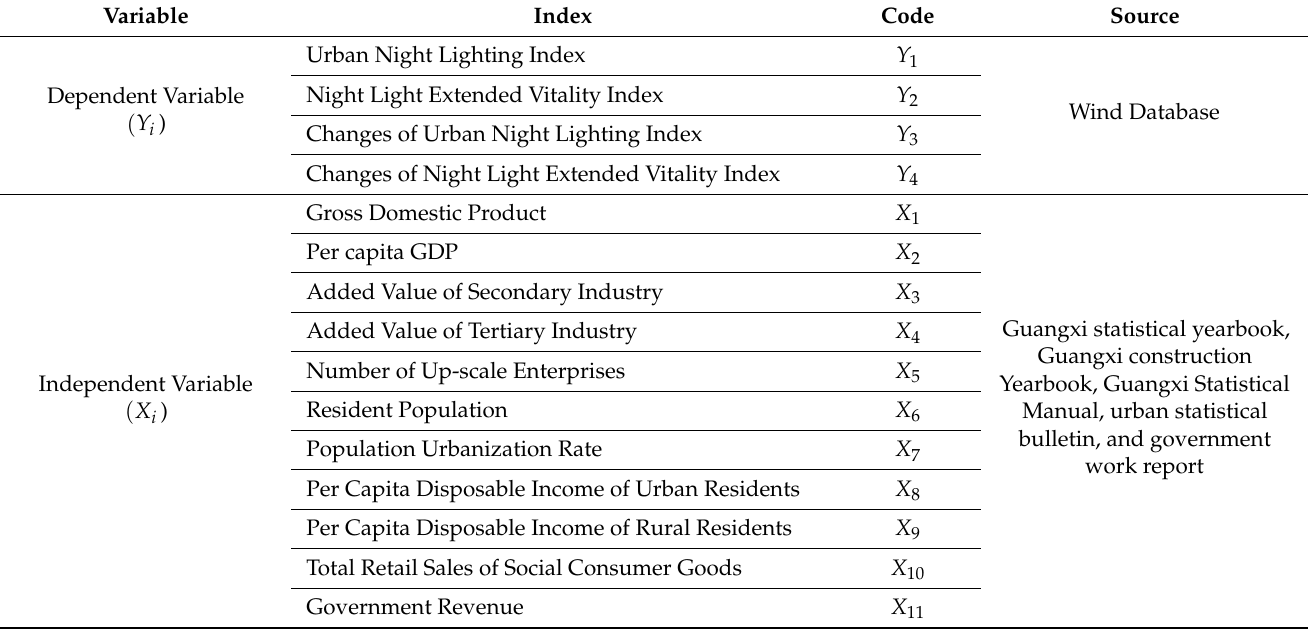
Table 2. Model variable